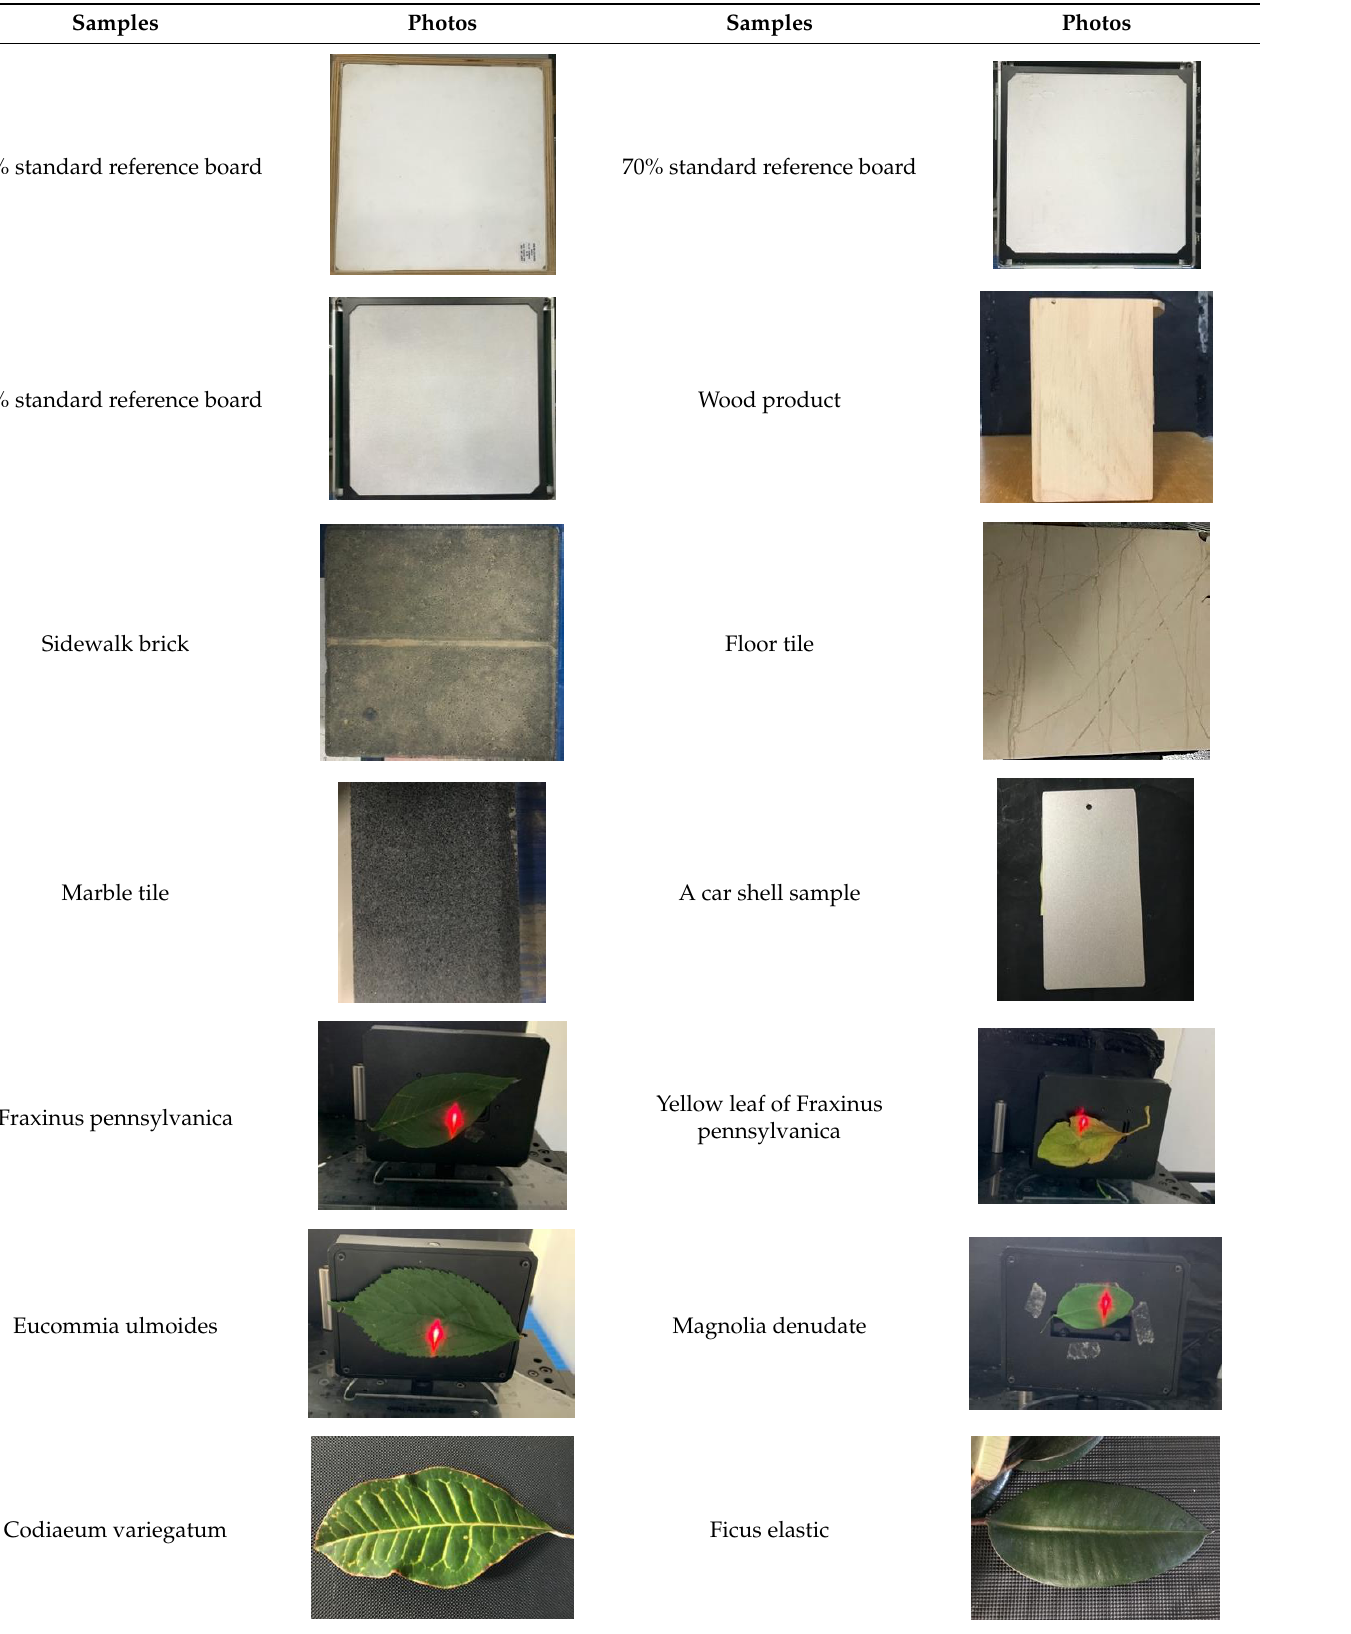
Table 1. Experimental samples and corresponding photos.